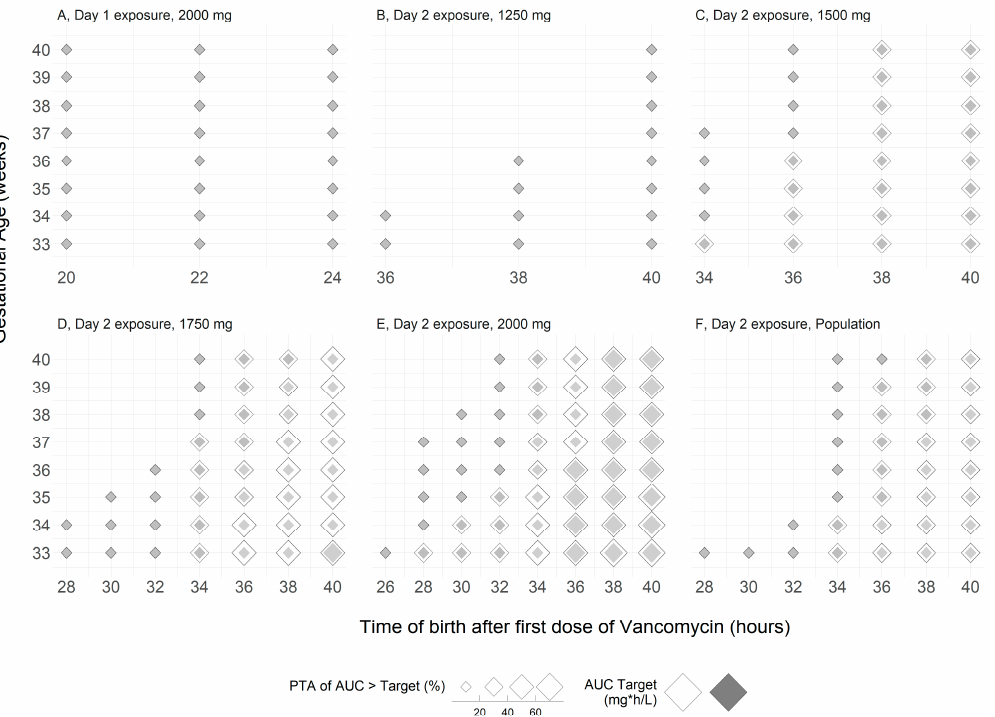
Figure 4. ( A – F ) Population and dose-wise newborn target attainment greater than the threshold of 10% for the toxicity indices (only PTAs > 10% are shown, for all other birth times and GAs the PTA is <10%). As an example, a newborn with GA of 35 weeks born at 34 h after initiation of intrapartum prophylaxis to a mother who received 5 doses of the 2000 mg prophylactic regimen is at 40% to 60% risk of exposure in excess of the AUC > 600 mg·h/L and has a 10% to 20% chance of exposure in excess of the AUC > 800 mg·h/L cutoff. For the toxicity index of the AUC > 600 mg·h/L, simulation results show early signs of excessive drug exposure in maternal serum for the population as a whole and all dosing schemes beyond 1250 mg with probabilities surpassing 27.6% for doses of 1500 mg or greater on day 1 and with the administration of three doses. On day 2, incremental in- crease in the chance of toxic maternal exposure is expected with subsequent doses given, showing the greatest risk at 83.9% with the current guideline recommended maximum dose of 2000 mg (Figure 5).